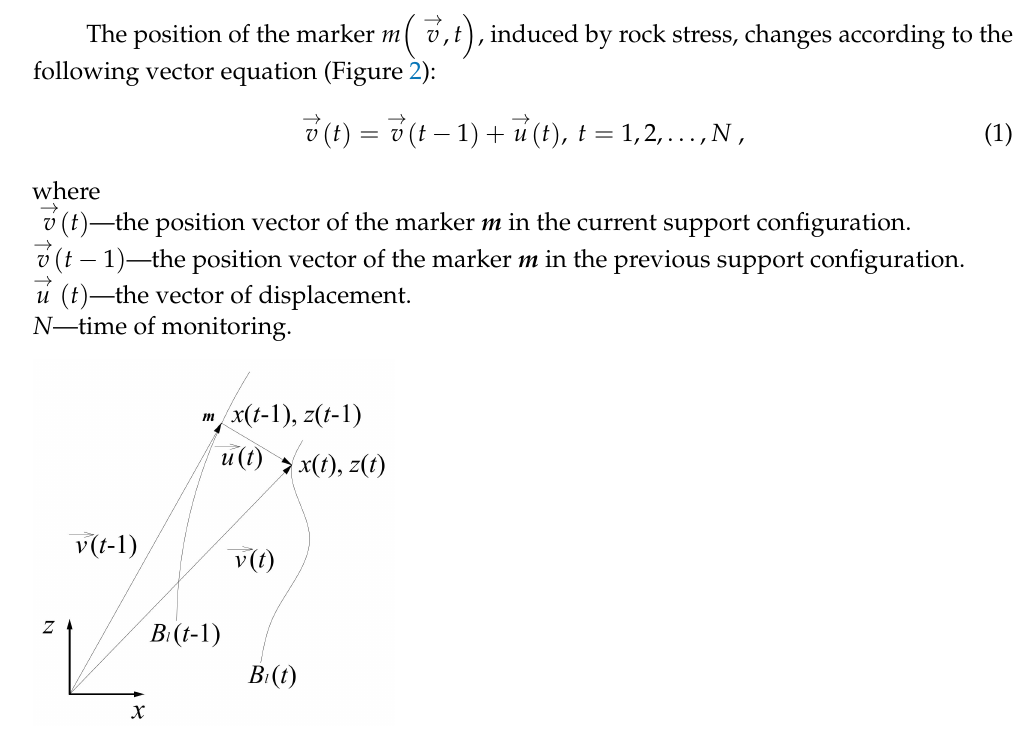
Figure 1. Transformation of real two-dimensional support to an artificial one-dimensional support.